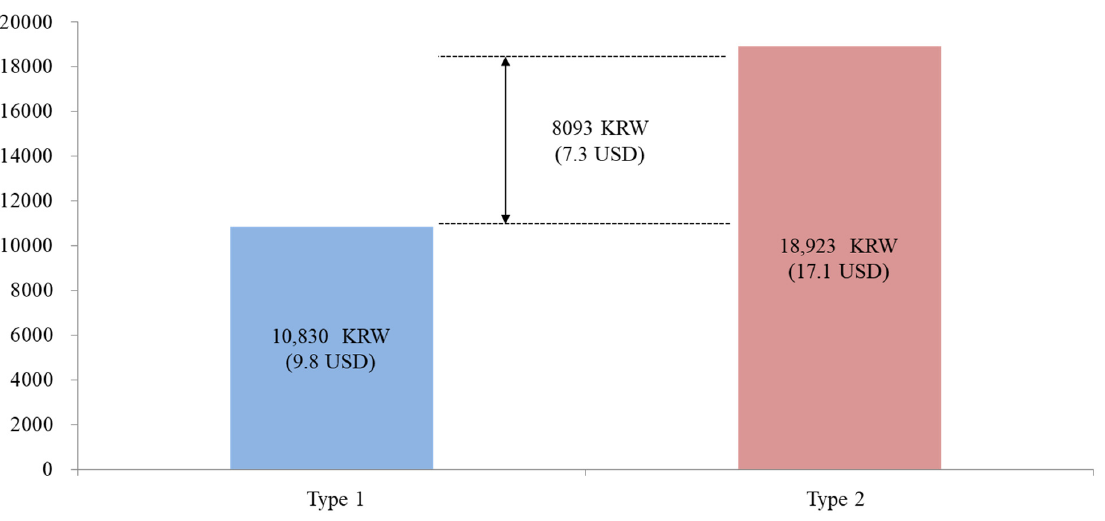
Figure 2. WTP for 1 person.